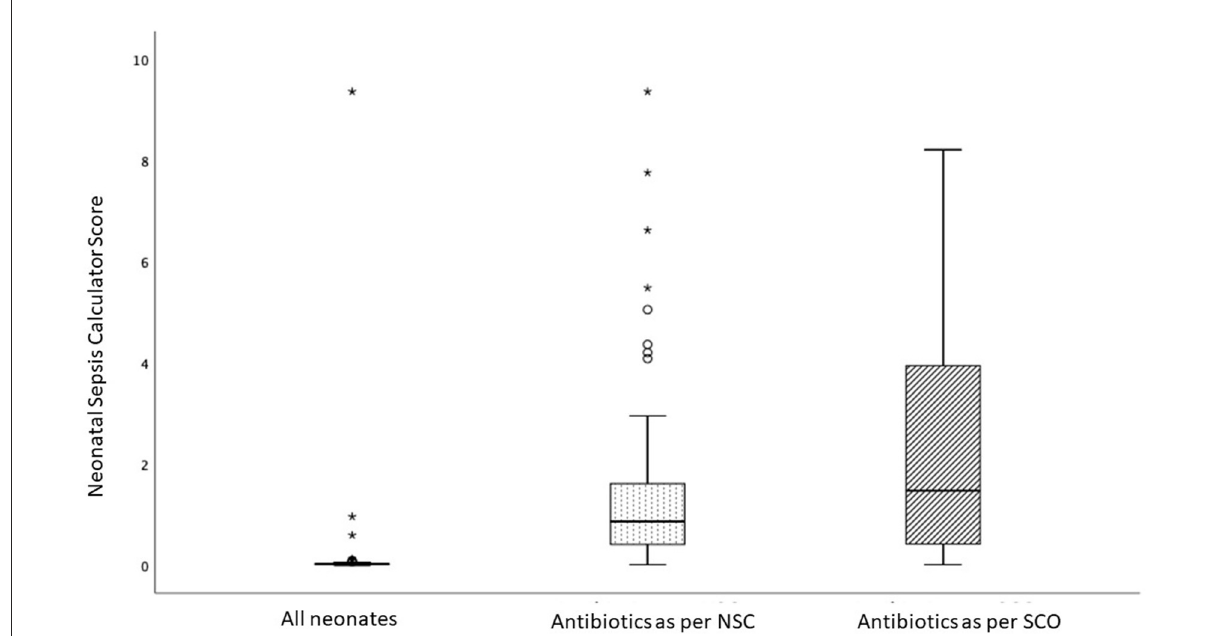
FIGURE2 Box-and-Whisker plot comparing the score of the Neonatal Sepsis Calculator (NSC) in three groups: all infants in the study (median score = 0.02; IQR 0.02), infants receiving antibiotics as per NSC (median = 0.86; IQR = 1.22) and infants recommended antibiotics by Serial Clinical Observation (SCO) (median = 0.86; IQR = 1.22). The score in the study population was low; infants recommended antibiotics as per SCO had higher scores compared with infants recommended antibiotics as per NSC. Each box bounds the IQR range divided by the median (solid horizontal line); the lower and upper margins of the box represent the 25th and the 75th centile, respectively. The whiskers extend 1.5 times the IQR from the median. A circle (o) is used to mark outliers with values between 1.5 and 3 box lengths from the upper edge of the box; the asterisk ( * ) is used for extreme outliers (a value more than 3 times the interquartile